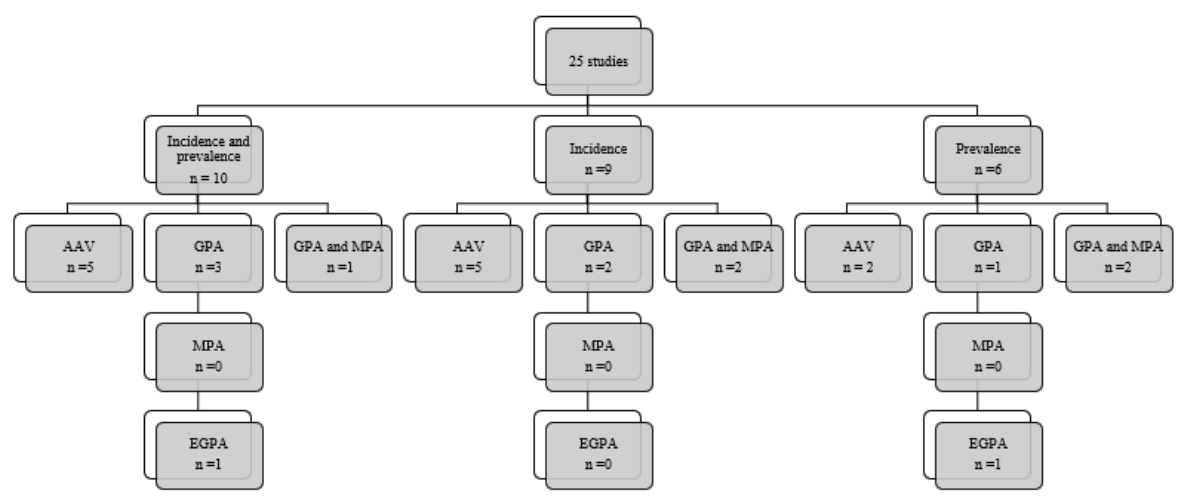
Figure 2. Types of vasculitis